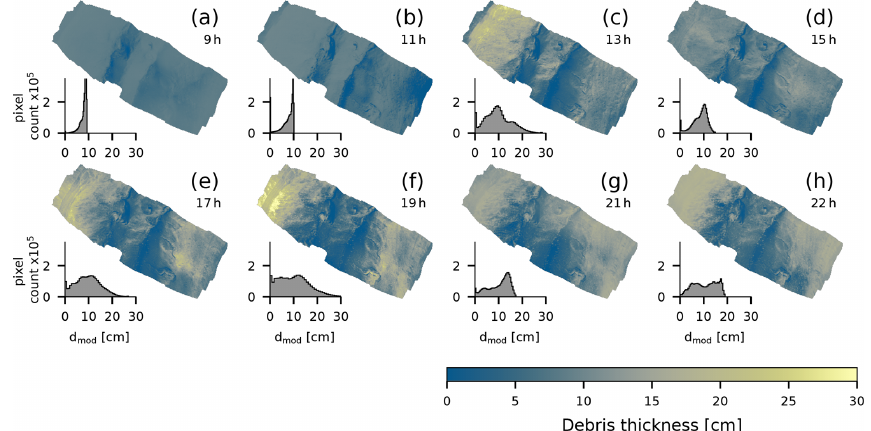
Figure 10. Estimated debris thickness using a rational function for each flight time. The histograms show the distribution of the predicted debris thicknesses displayed in the